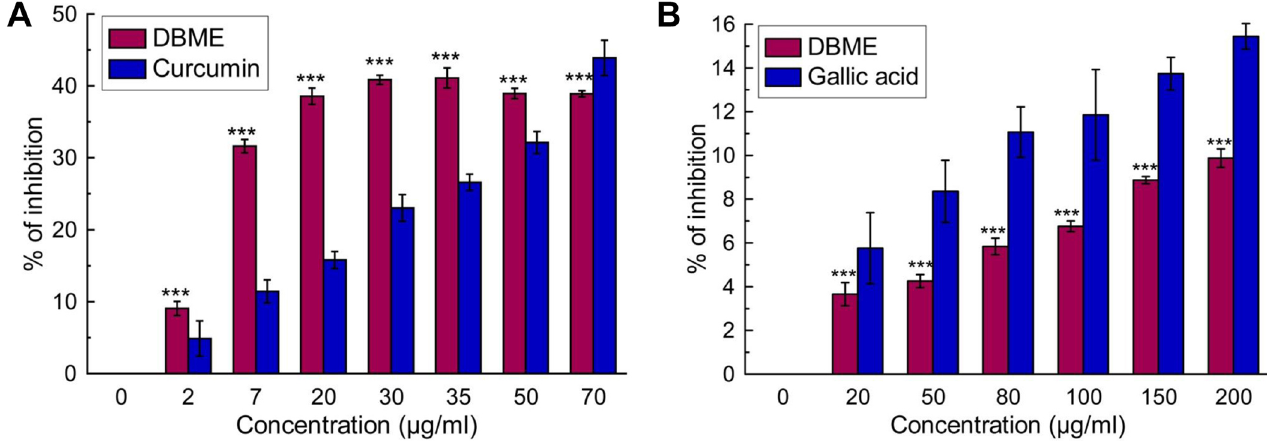
Fig 3. Reactive nitrogen species scavenging activity of DBME and the reference compounds. (A) Nitric oxide inhibition, (B) peroxynitrite radical scavenging. The results are mean ± S.D. of six parallel measurements. *** p < 0.001 vs. 0 μ g/ml.